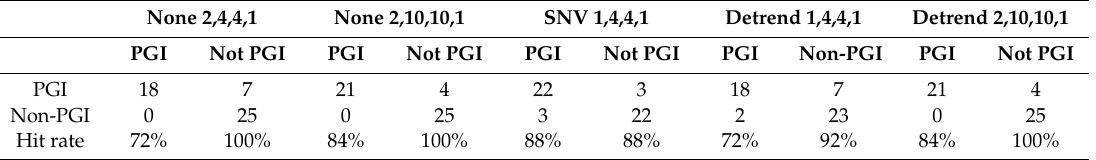
Table 2. Discrimination results (number of samples and percentage of samples correctly classified) of residual mean squares (RMS-X) residuals method for some of the mathematical treatments assayed.